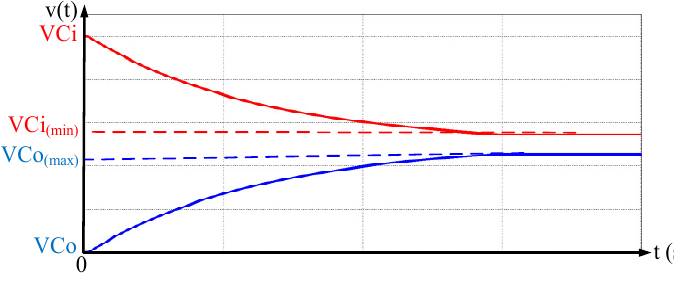
Figure 23. Waveforms representing a capacitor discharging into another capacitor in partial charge mode.